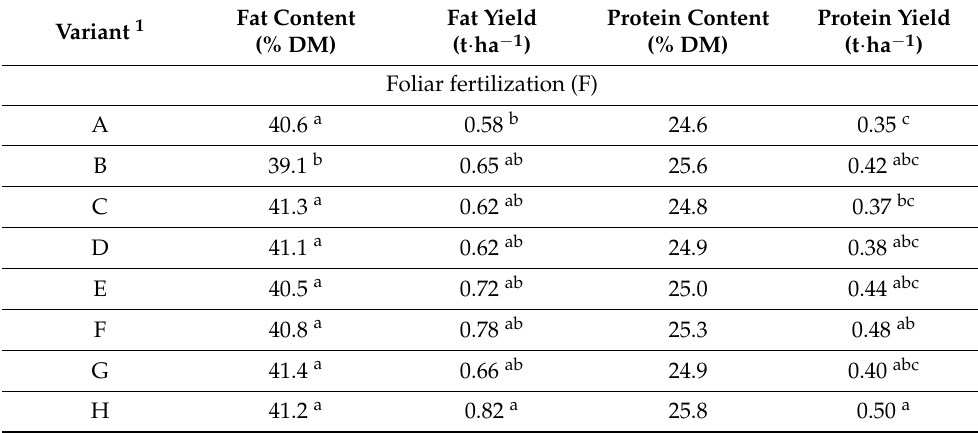
Table 4. Chemical composition of seeds and yield of fat and protein.